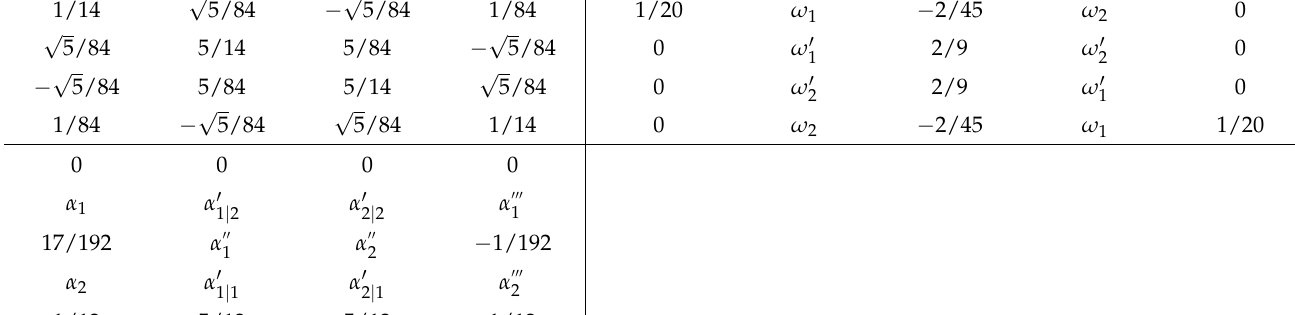
Table A9. L4|L5 method.